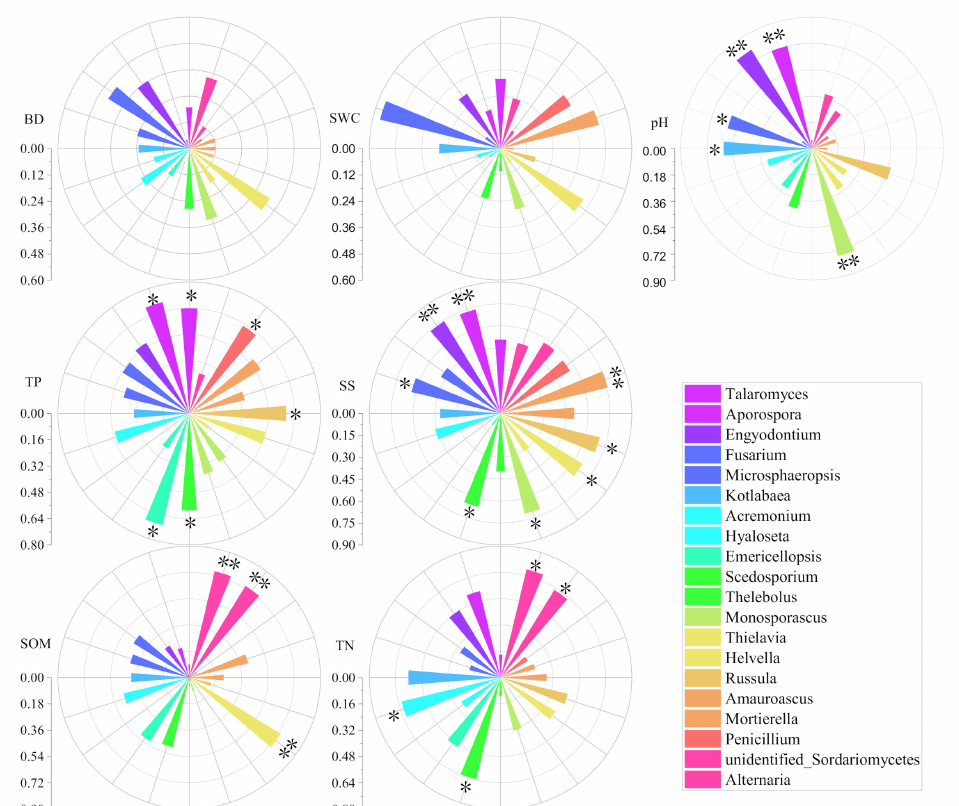
Figure 6. Rose diagrams, demonstrating the influence of the soil environmental factors on the relative abundance of soil fungi at the genus level. The longer petals indicate the greater influence of the soil environmental factors on the relative abundance of the soil fungi. BD, SWC, SS, SOM, TP, and TN are the soil bulk density, soil water content, soil salinity, soil organic matter, total phosphorus, and total nitrogen, respectively. * p < 0.05. ** p <